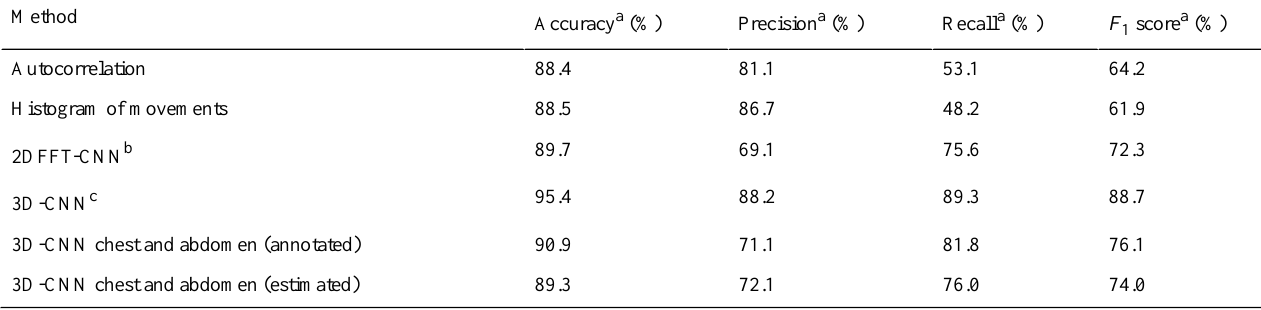
Table 4. Obstructive apneas versus central apneas: prediction performance of different